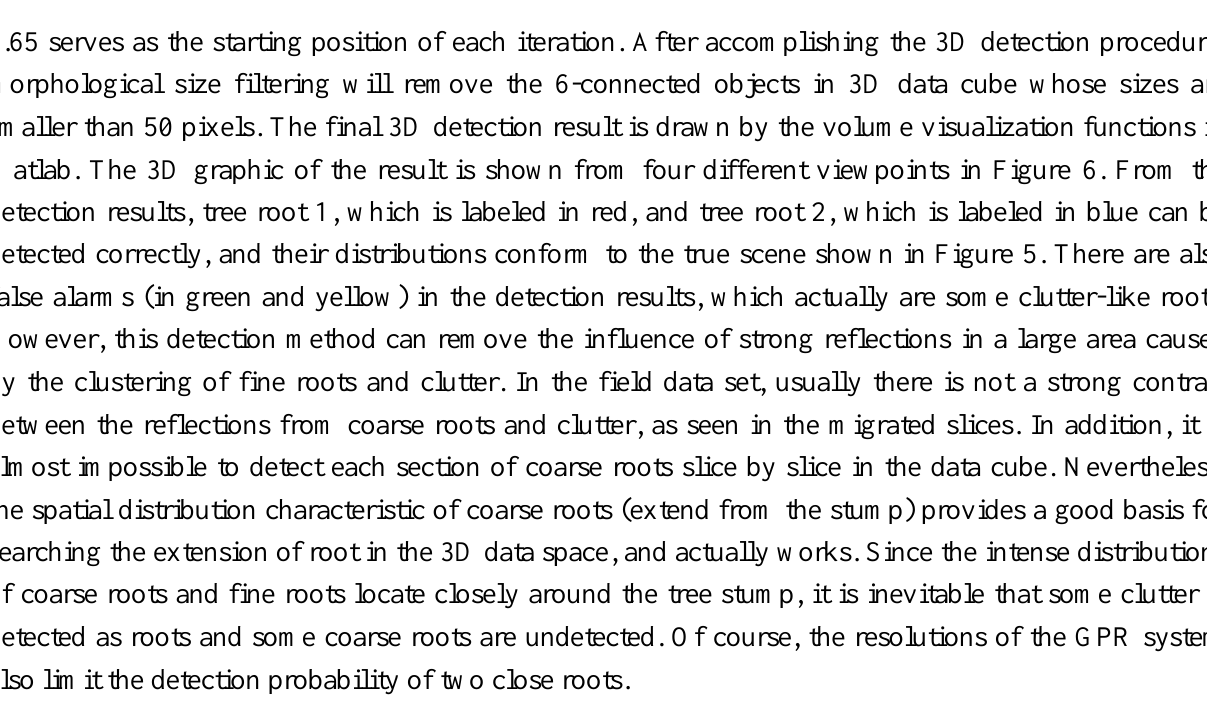
Figure 6. ( a – d ) Visualization of 3D detection results of the tree root using Matlab in different viewpoints, red arrows indicate